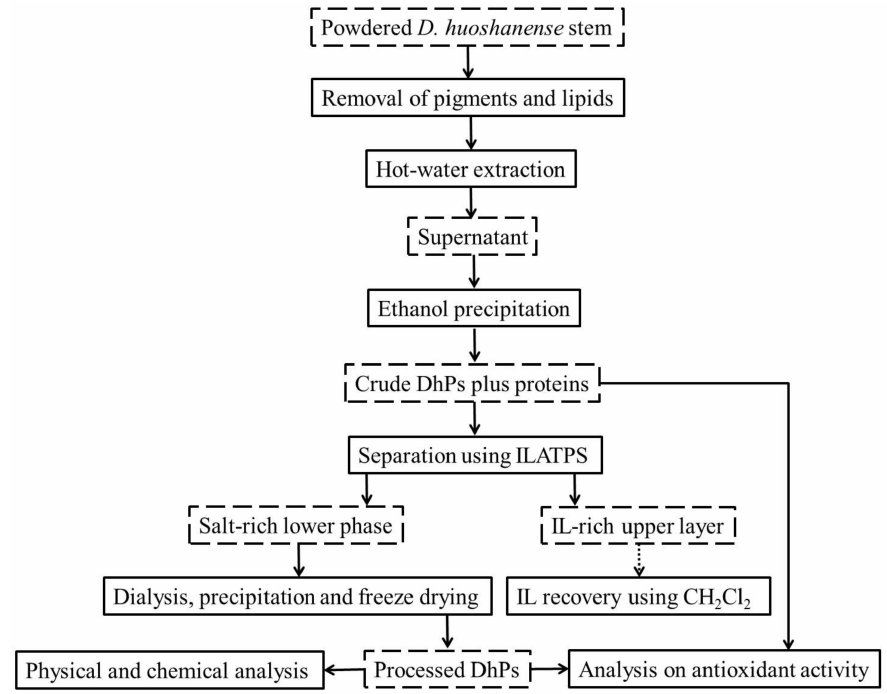
Figure 7. Flowchart for separation of D. huoshanense polysaccharides and